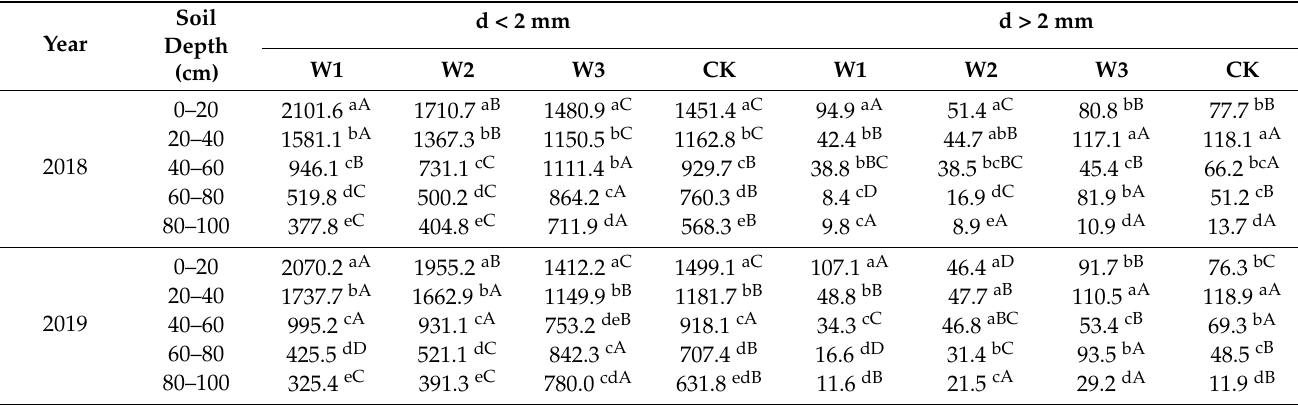
Table 3. Distribution of RLD of absorption roots (d < 2 mm) and conducting roots (d > 2 mm) of jujube in different treatments in 2018 and